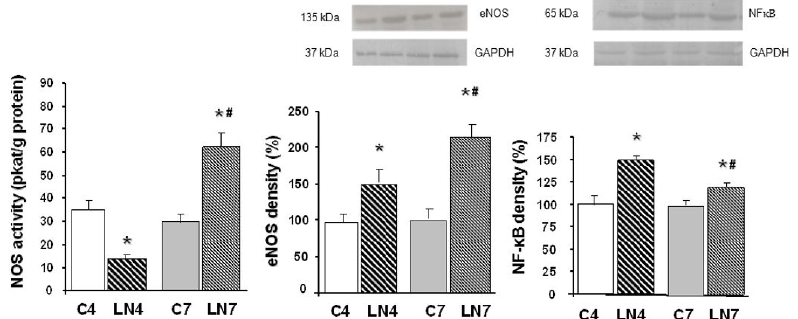
Figure 2. E ff ect of 4- and 7-week N G -nitro-L-arginine methyl ester (L-NAME) treatment on NO synthase (NOS) activity, endothelial NOS (eNOS) protein expression, and nuclear factor-kappaB (NF- κ B, p65) protein expression in the aorta. Group treated with L-NAME for 4 weeks (LN4) and age-matched controls (C4), group treated with L-NAME for 7 weeks (LN7) and age-matched controls (C7). * p < 0.05 compared to age-matched controls, # p < 0.05 compared to LN4.